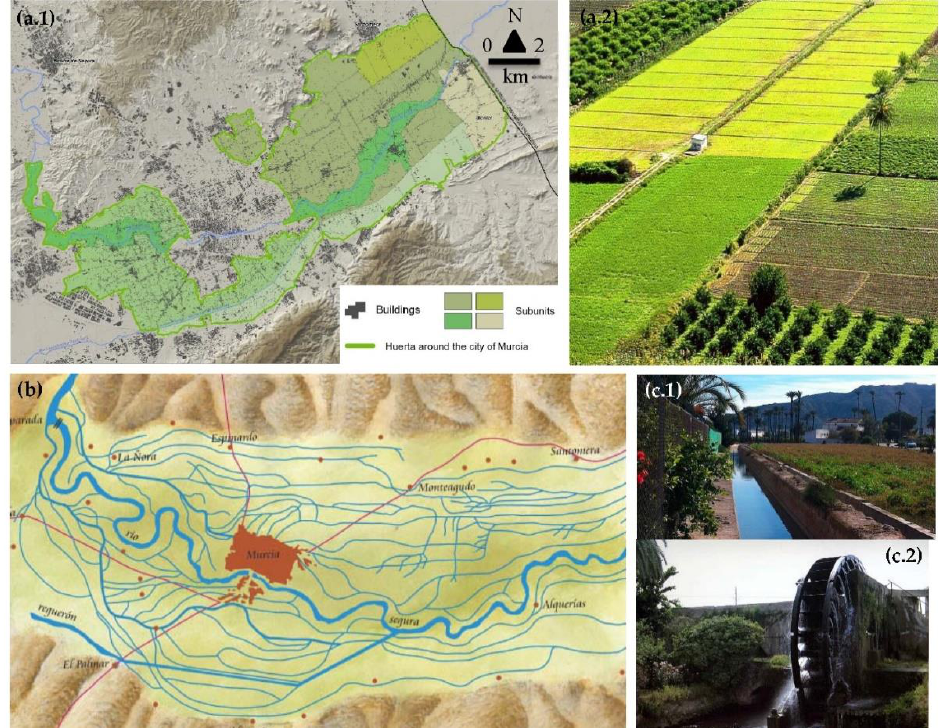
Figure 10. The Huerta de Murcia traditional landscape: ( a.1 ) Extension of the area and subunits of the Huerta directly linked to the metropolitan area of the city of Murcia ( a.2 ) example of its traditional landscape, ( b ) scheme of the traditional agricultural hydrographic network of the Huerta and ( c.1 , c.2 ) traditional hydraulic infrastructures existing since the Muslim period (8th – 14th century).